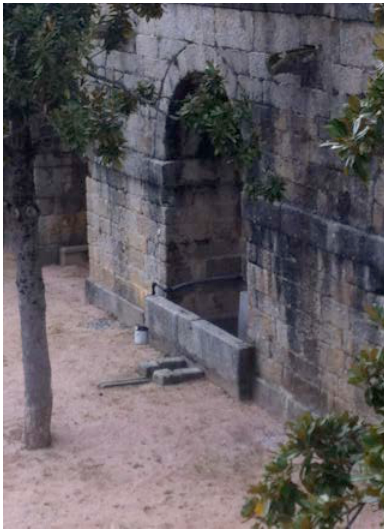
Figure 4. Eastern façade of the Monastery (Muro de los Nichos or Wall of the Niches), showing the stains of damp on the stone masonry walls.